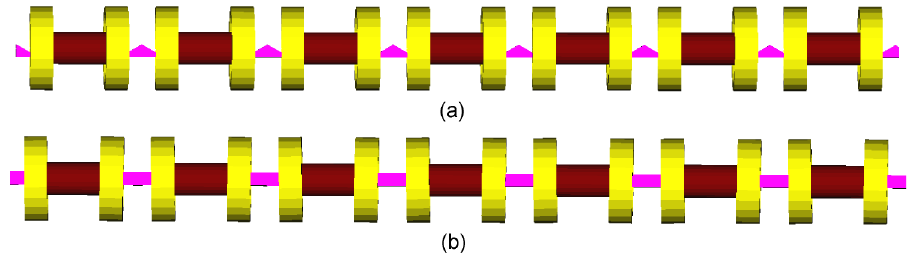
FIG. 2. Conceptual design of a rectilinear channel: (a) top view; (b) side